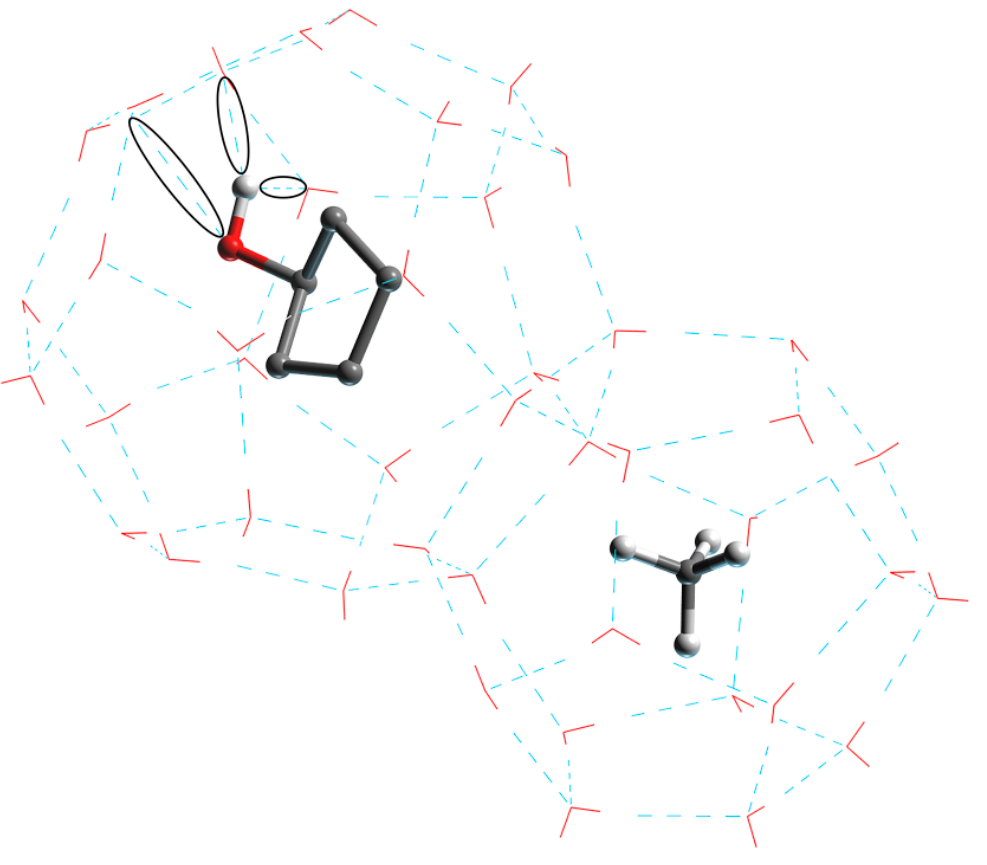
Figure 8. Structure of LCCBM hydrate cages in the presence of CP-ol molecules with new hydrogen bonds between water and CP-ol molecules.